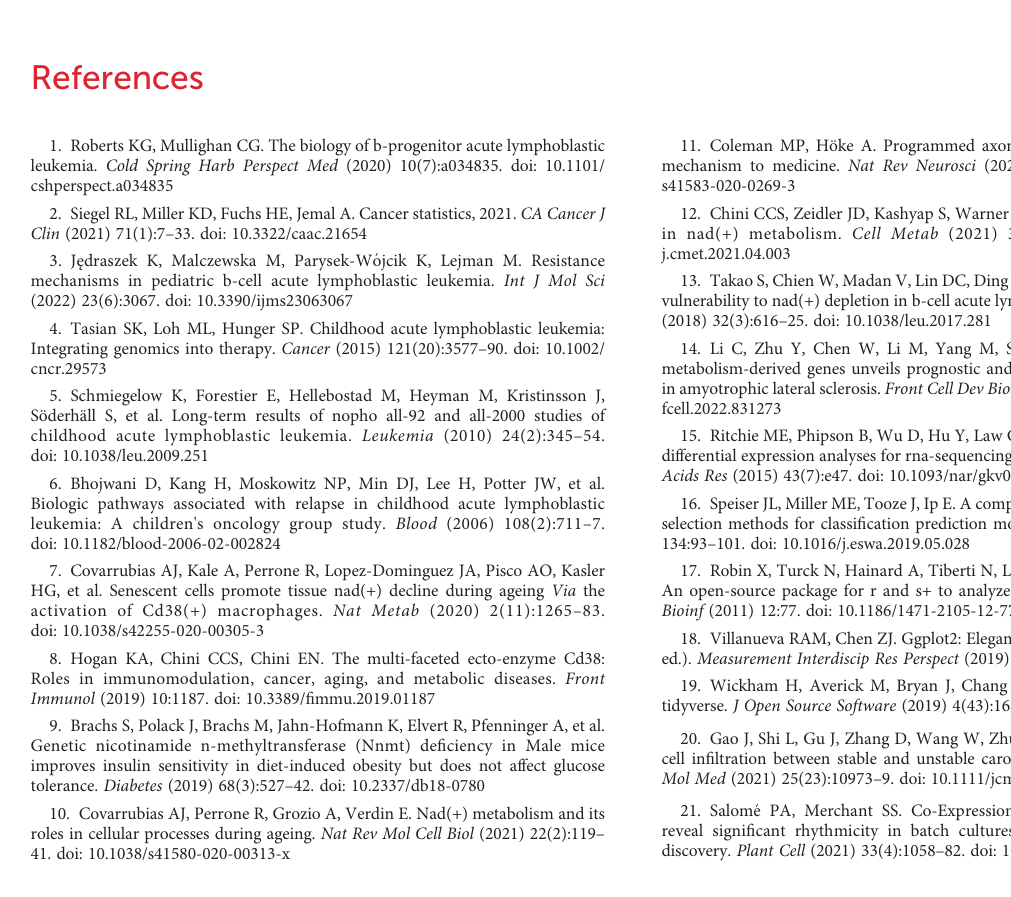
SUPPLEMENTARY TABLE 3 Primers for qPCR used in the